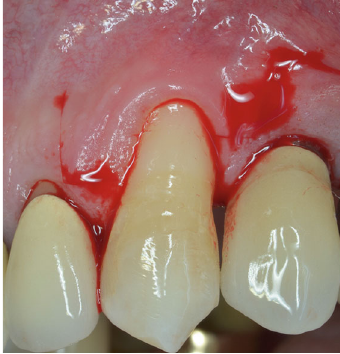
Figure 5: A trapezoidal fl ap is designed with vertical releasing incisions arriving just at the mucogingival junction.